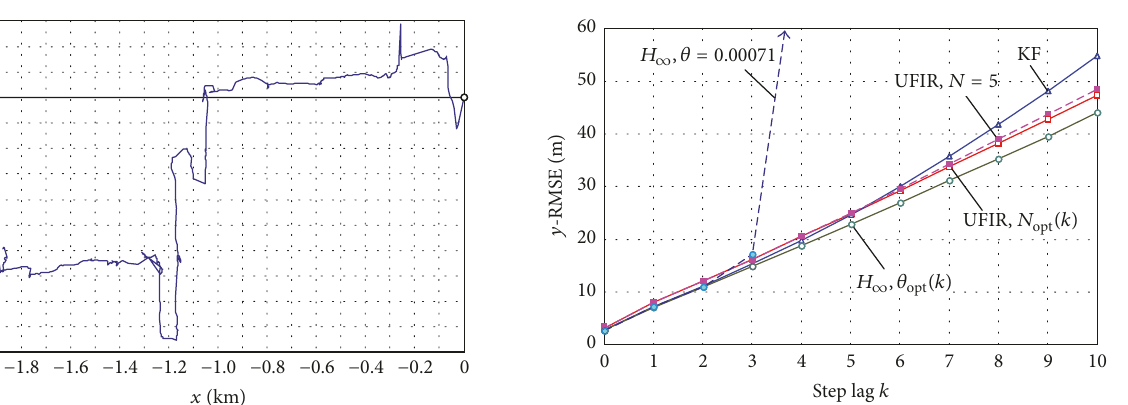
Figure 2: GPS-based vehicle trajectory measured in the north ( 𝑦 ) and east ( 𝑥 ) coordinates, both in km, with the start point at {0, 0} . Measurements are provided each second at 858 data points.